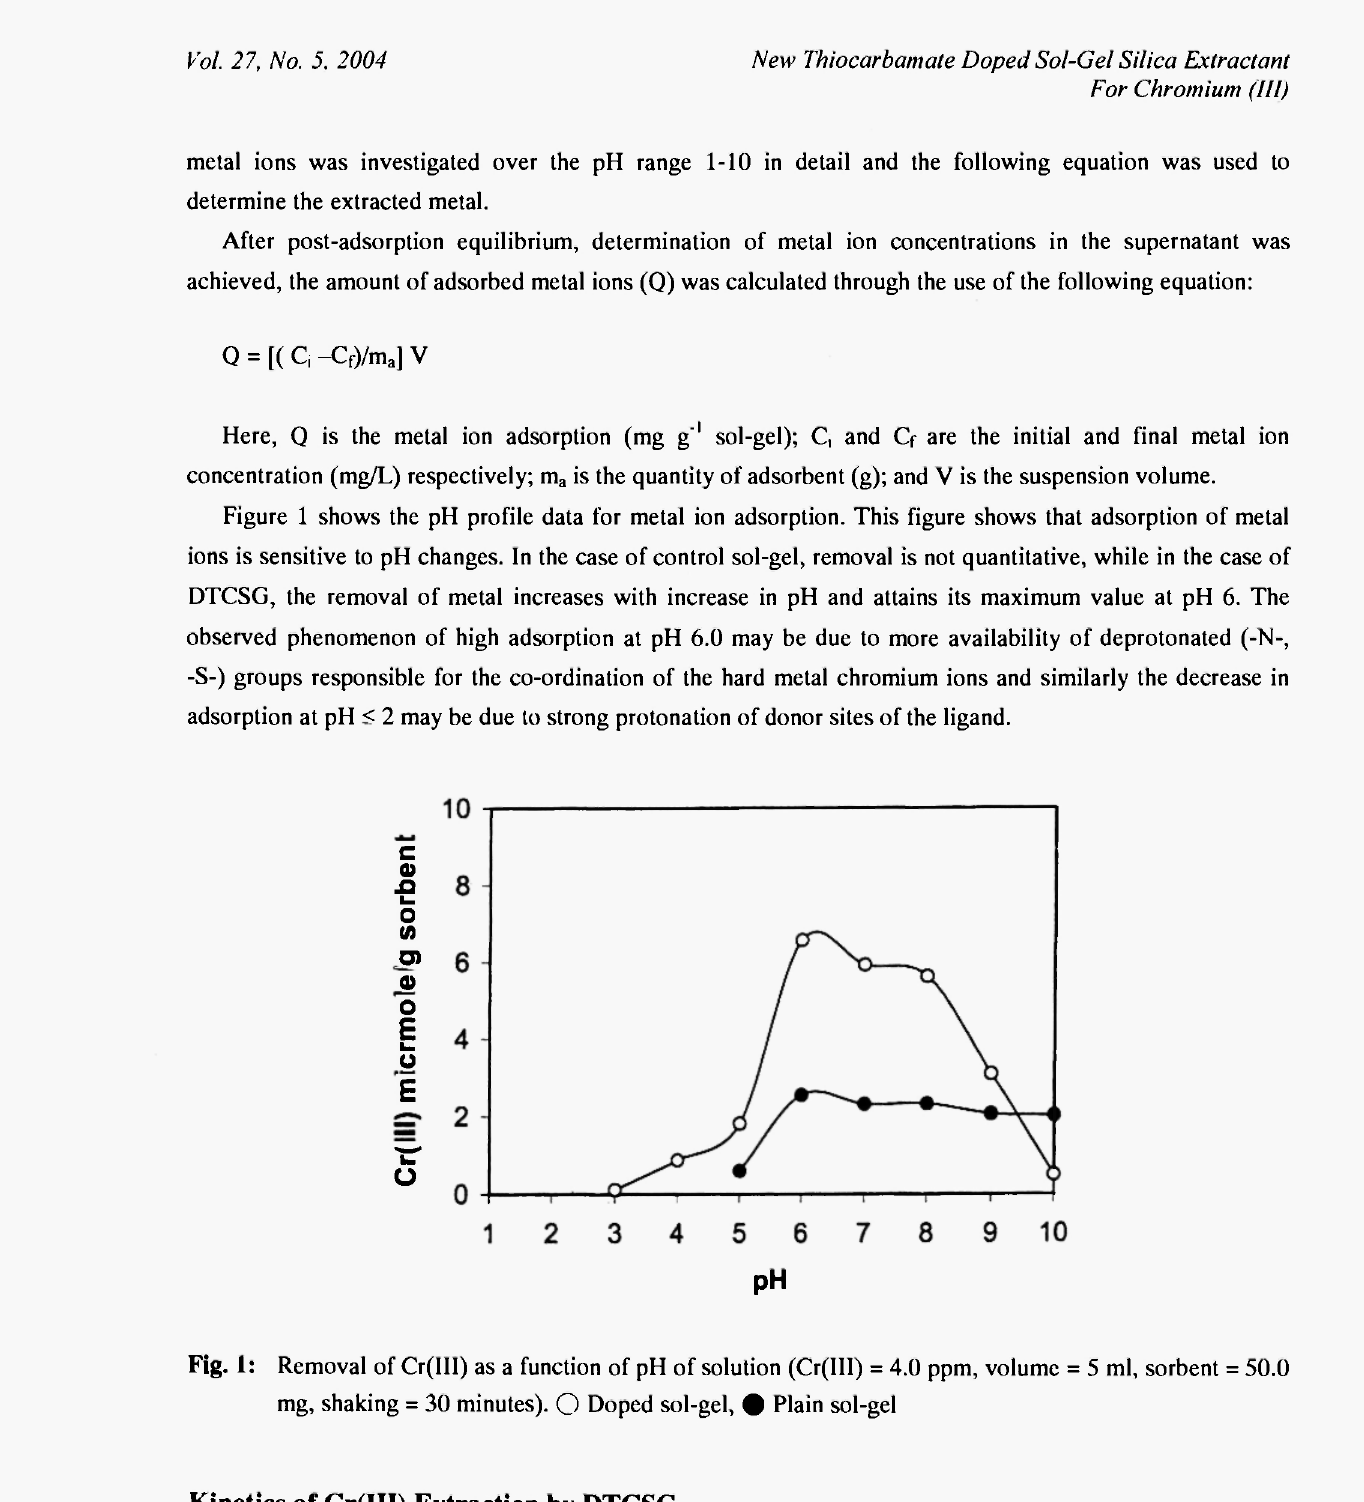
Kinetics of Cr(III) Extraction by